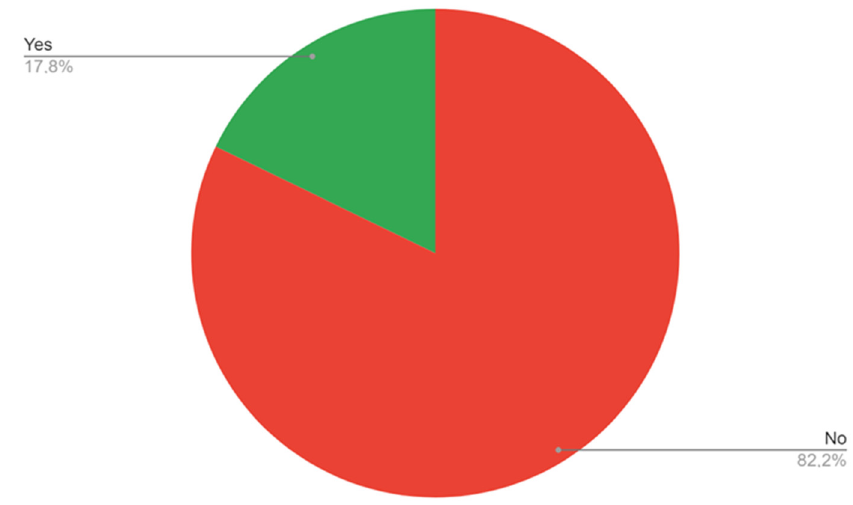
Figure 4. Access to ABI measurements in the respondents’